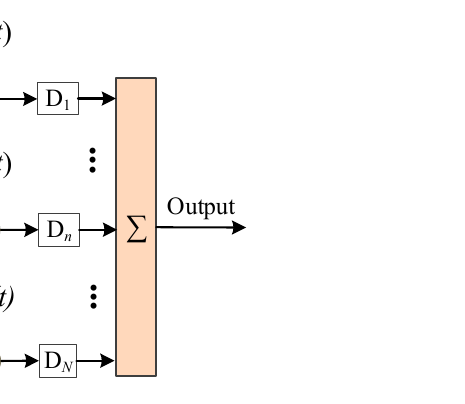
Figure 2. Flowchart of the conventional DBF processor with phase and time delay compensation.